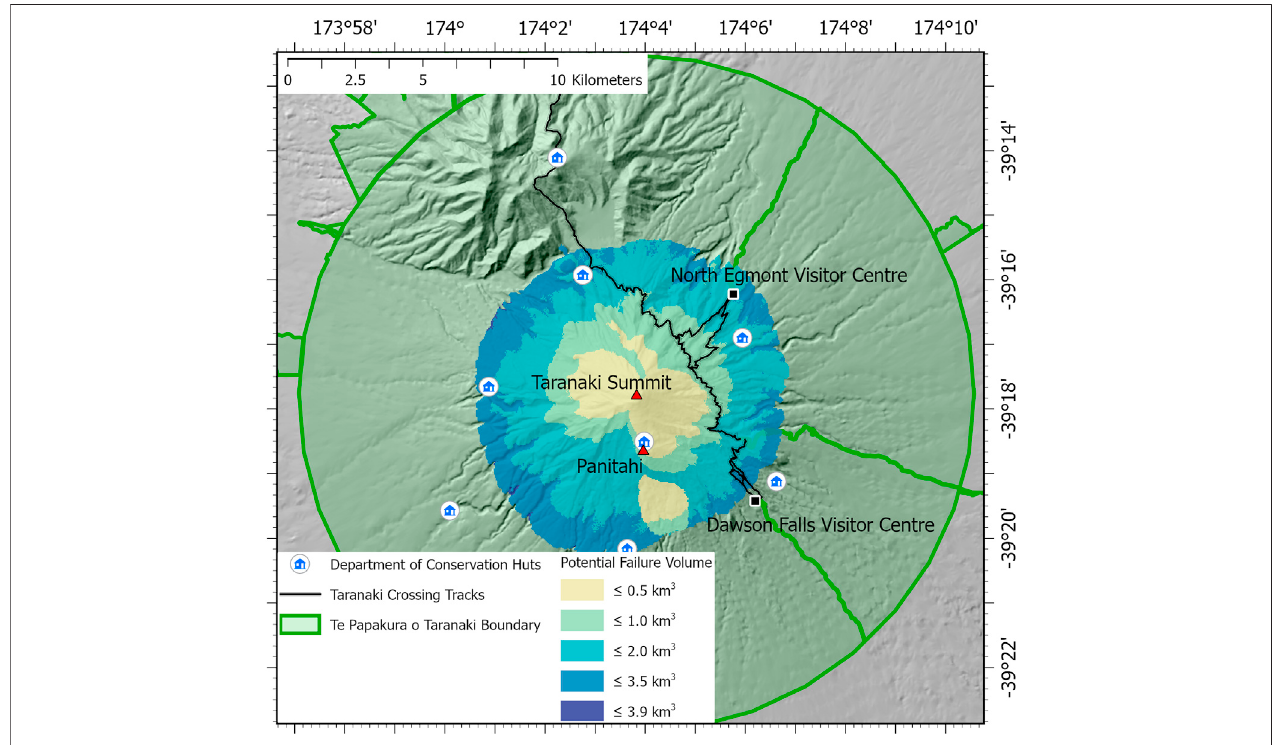
FIGURE 10 | Potential failure volumes for FOS < 3.0 at Mt. Taranaki.